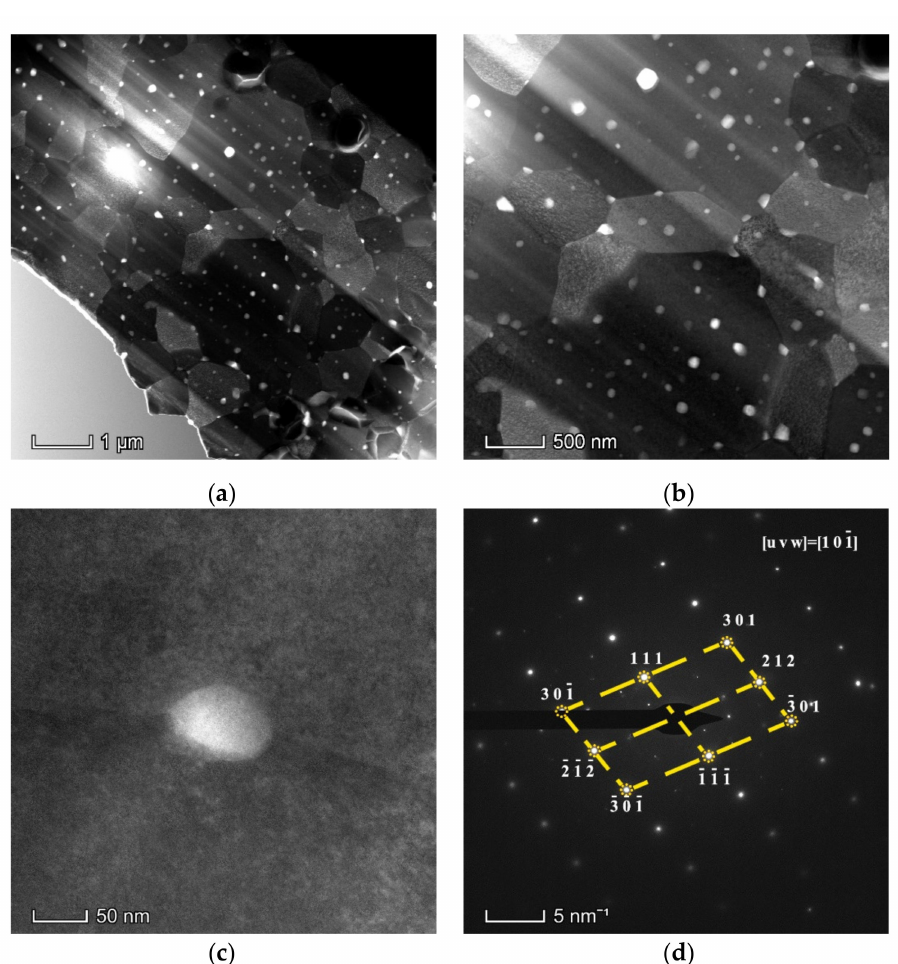
Figure 6. ( a – c ) TEM images of the sintered W-TiC alloys, and ( d ) selected area electron diffraction (SAED) image of the particle in ( c ).